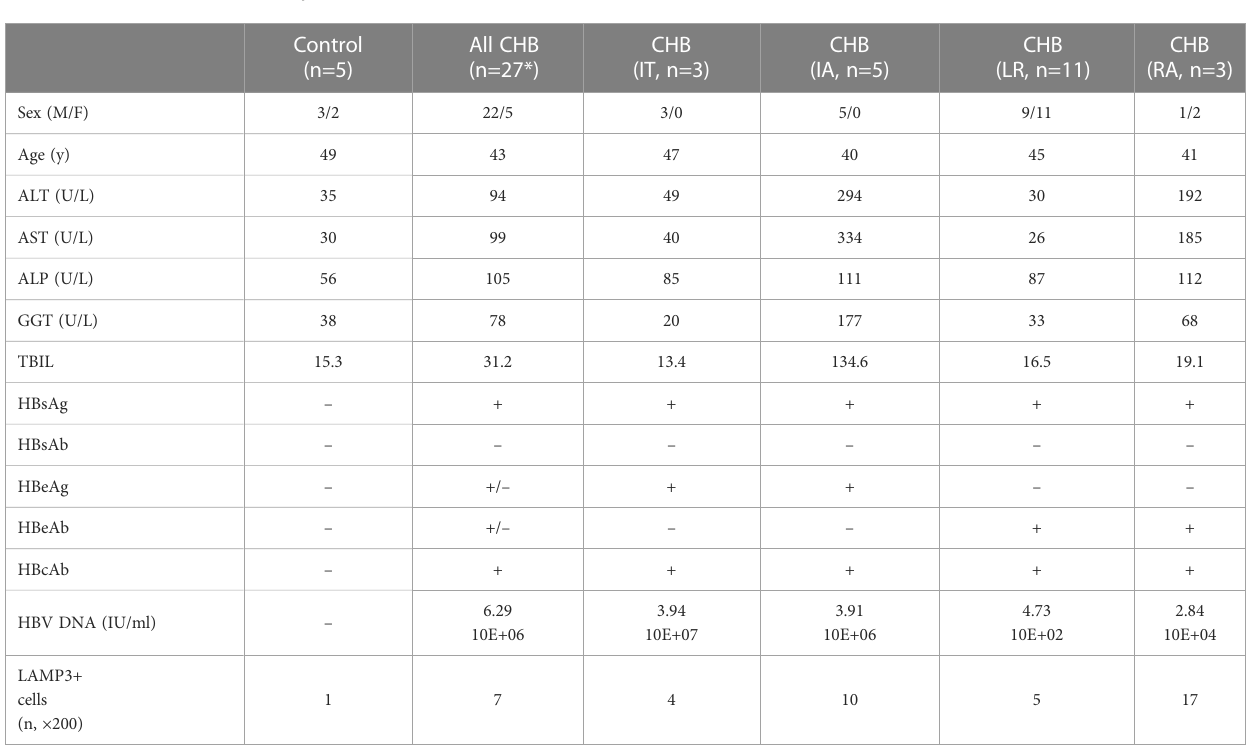
TABLE 2 Clinical information of 27 patients with